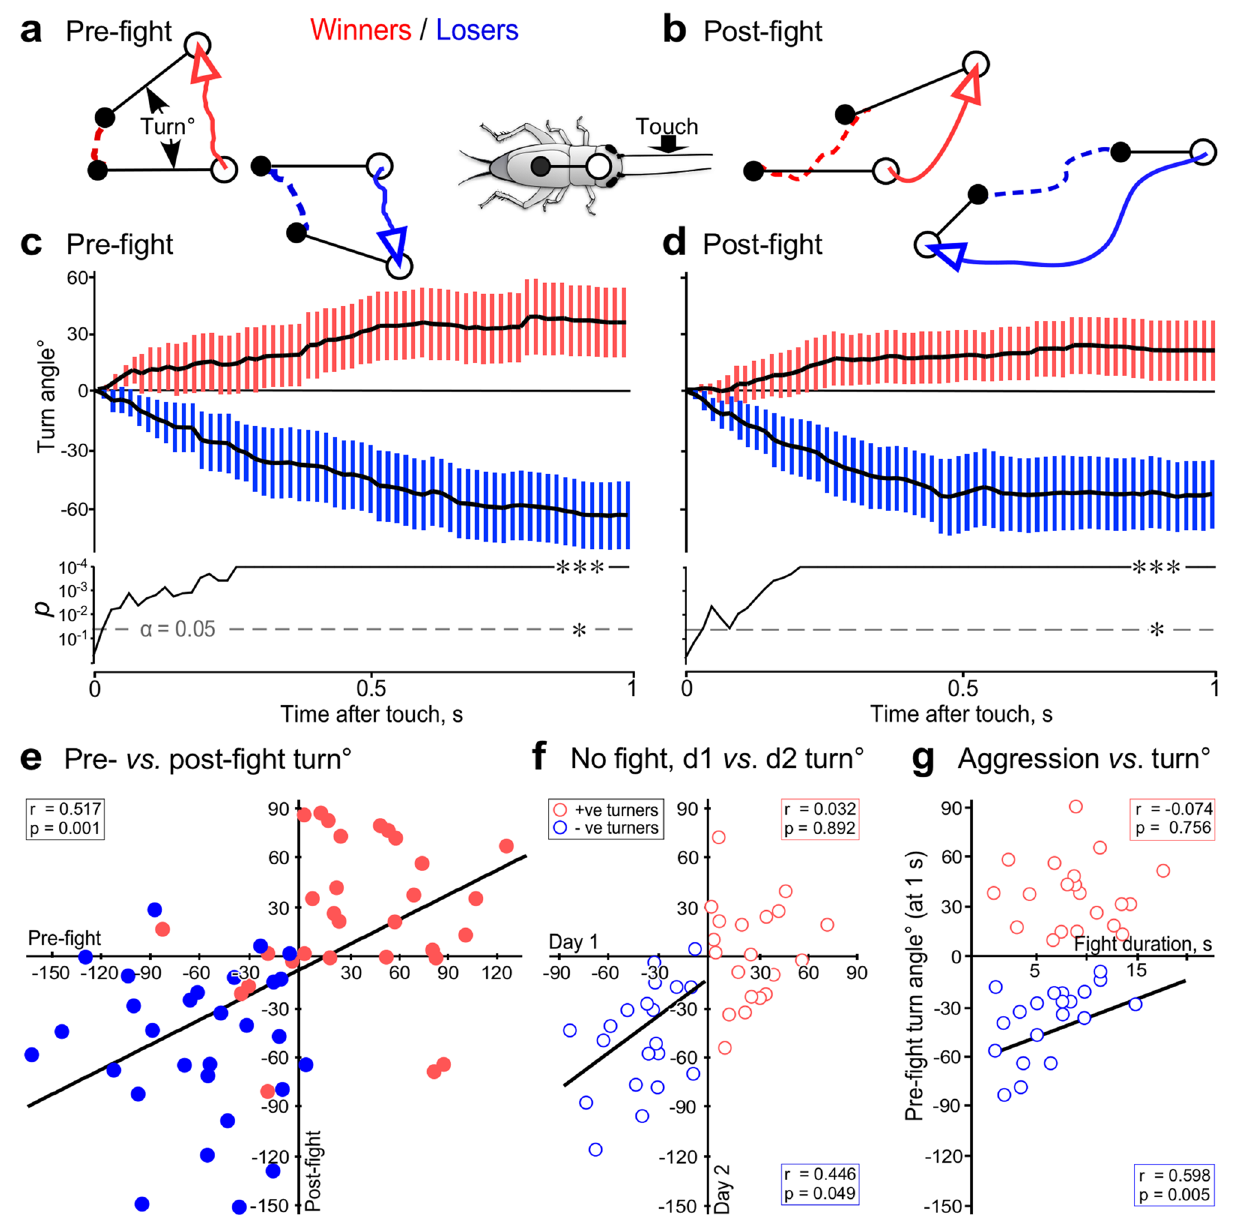
Figure 2. Turning responses and aggression in short term isolates (STI). ( a ) Original tracks of responses to the touch stimulus in a prospective winner and loser (red respectively blue arrows; black lines: body orientation; full circle: body; open circle: head). ( b ) Same animals as in ( a ) 1 h after their first fight. ( c ) Top graph: sequential plots of mean turn angles (black lines) for every frame with 95% CI (bars, red: prospective winners; blue: prospective losers; n = 30 each). Bottom graph: significance of difference p between prospective winners and losers, * p < 0.05, *** p < 0.001. ( d ) As for ( c ) 1 h after first fight. ( e ) Plots of pre-fight versus post-fight turning responses for data depicted in ( c,d ). ( f ) Plots of turn angles on two consecutive days without an interposing fight. Red and blue open circles indicate individuals showing positive (+ ve), respectively negative (−ve) turns at the first trial, n = 20 each. ( g ) Plots of fight duration against hyper-aggressive opponents versus pre-fight turn angle for positive and negative turners (red and blue open circles respectively, n = 20 each). All components of the figures were created with canvas DRAW 5 for MAC (Version 5.0.2, ACD Systems, https:// www. acdsy stems. com/